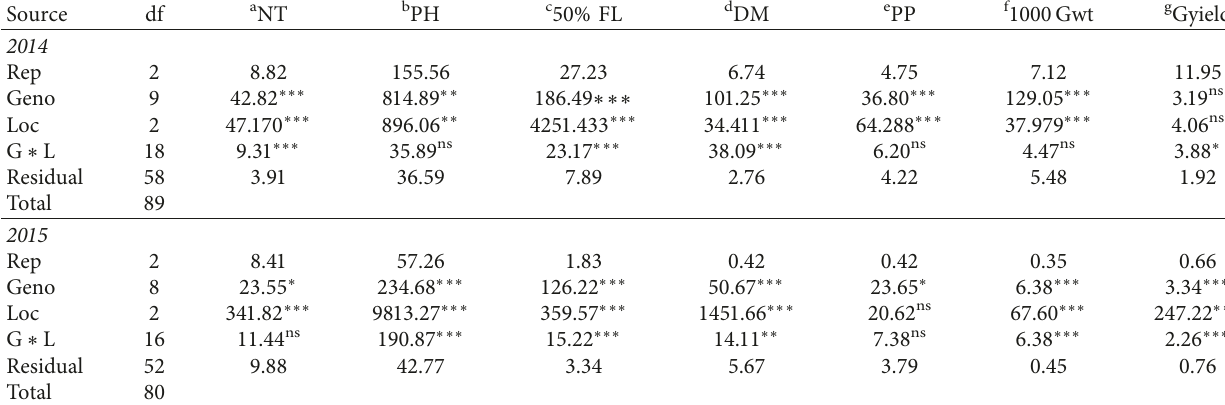
Table 4: Combined ANOVA mean squares for seven traits evaluated on hybrids and checks across locations in 2014 and 2015. Source